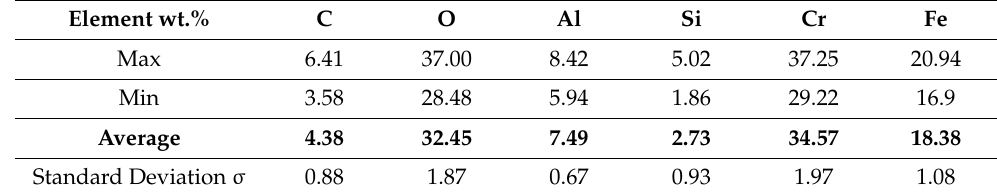
Table 2. Elemental wt.% contents of chromite sand CS in the analysed area (in Figure 3b). Element wt.%